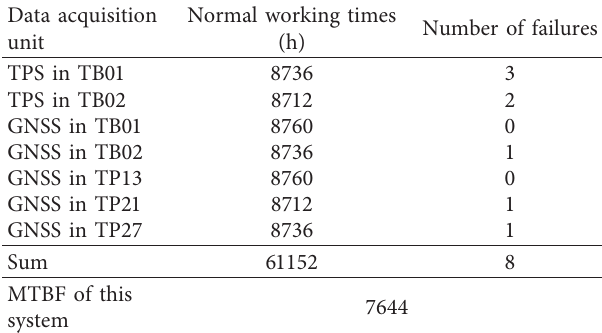
Table 3: Relative error between the TPS-GNSS concurrent monitoring data and artificial monitoring data. Points and modes